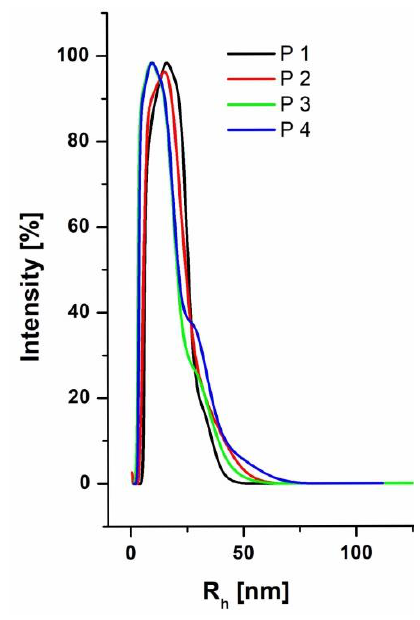
Figure 3. Distribution of the hydrodynamic radii of P(DMAEMA- co -OEGMA-OH) stars in PBS.